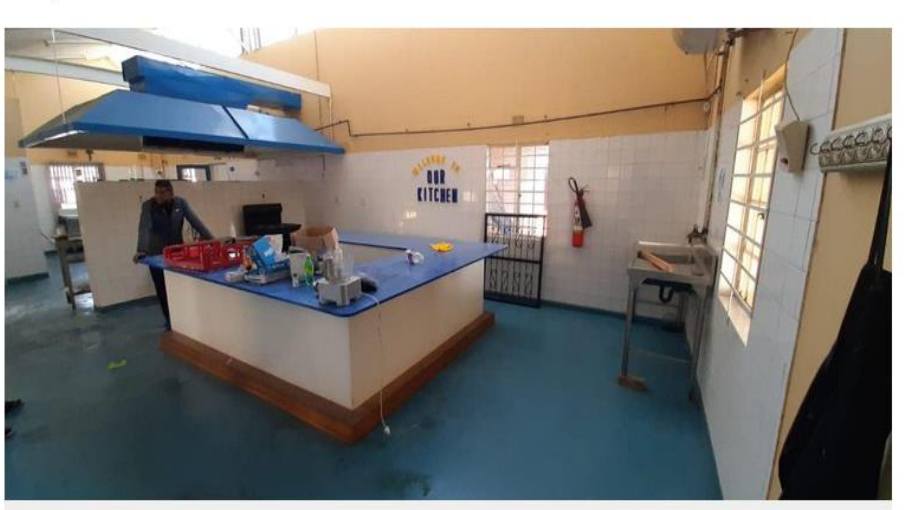
Plate 3: Golden Steps Kitchen looted (Source: Majola